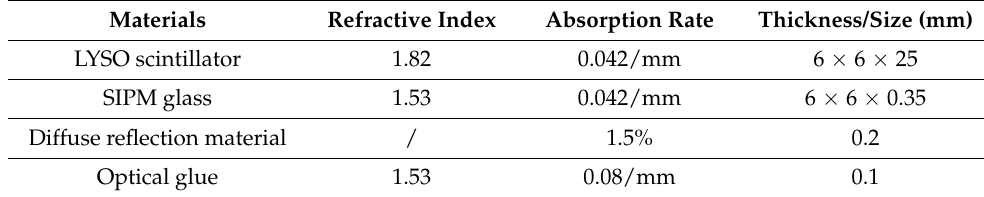
Figure 1. Detector models: ( a ) single-ended readout, ( b ) dual-ended readout, ( c ) side dual-ended readout, and ( d ) triple-ended readout. readout, and ( d ) triple-ended readout. Table 1. Parameters in